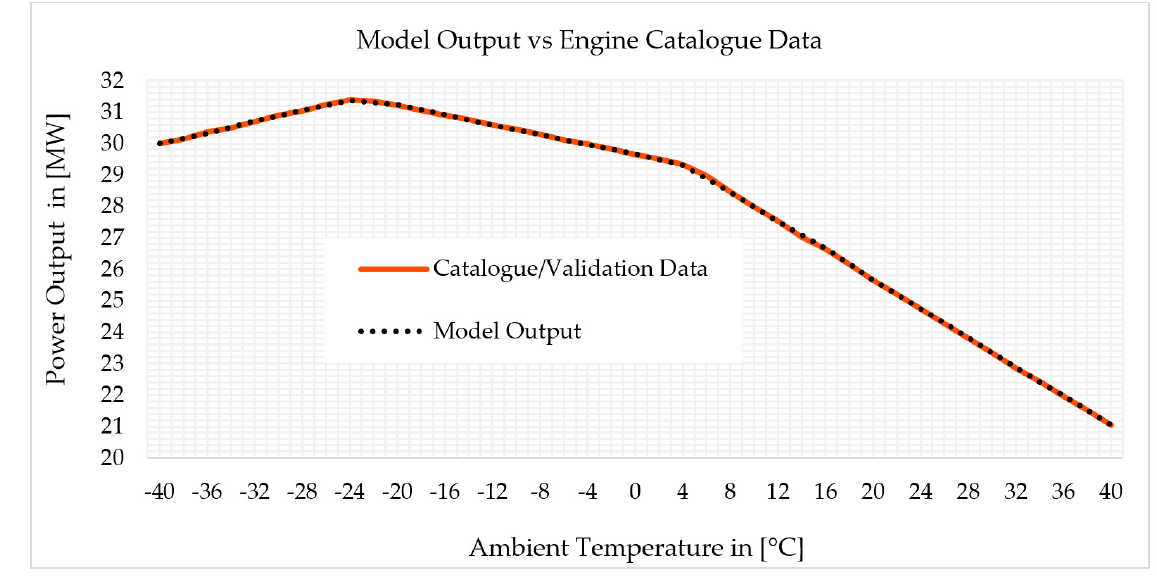
Figure 5. Validation of off-design model with power output (validation data) .